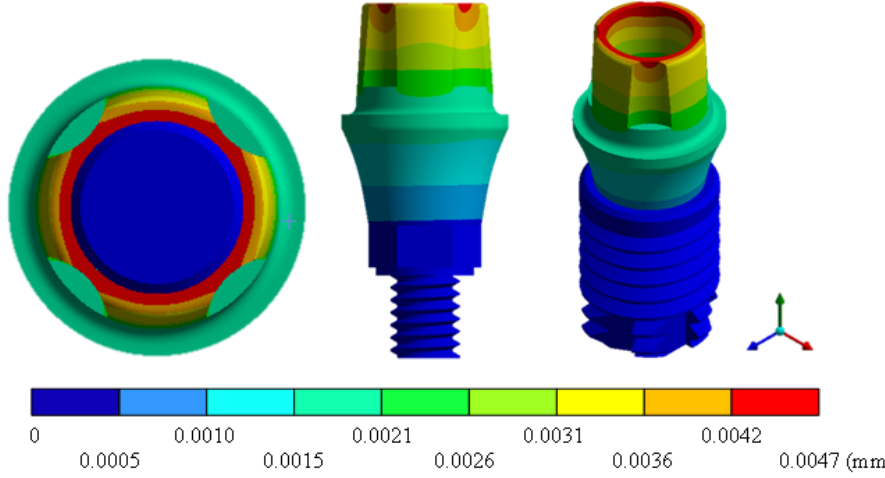
Figure 17. Total general displacement for Snappy-type implant (ZrO 2 ).